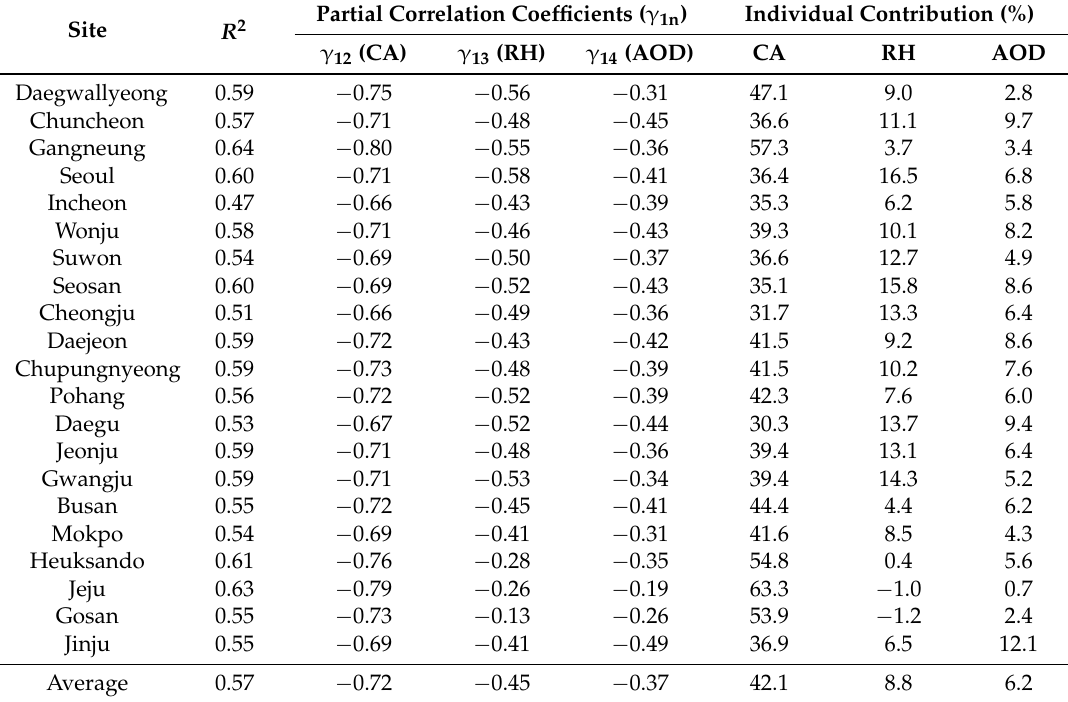
Table 3. Partial correlation coefficients of CA, RH, and AOD with K T variations, and combined ( R 2 ) and individual contributions to variations in K T